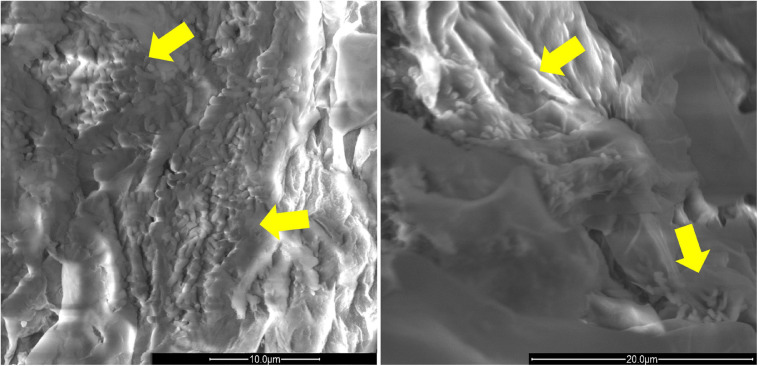
Scan electron microscopy images of L. corniculatus roots inoculated with O. haematophilum P6BS-III and R. sp. P44RR XXIV. Yellow arrows indicate the location of the microbial cells in the root surface. The image has been magnified 8000 times. On the left, O. haematophilum P6BS-III. On the right, Rhizobium sp. P44RR XXIV.